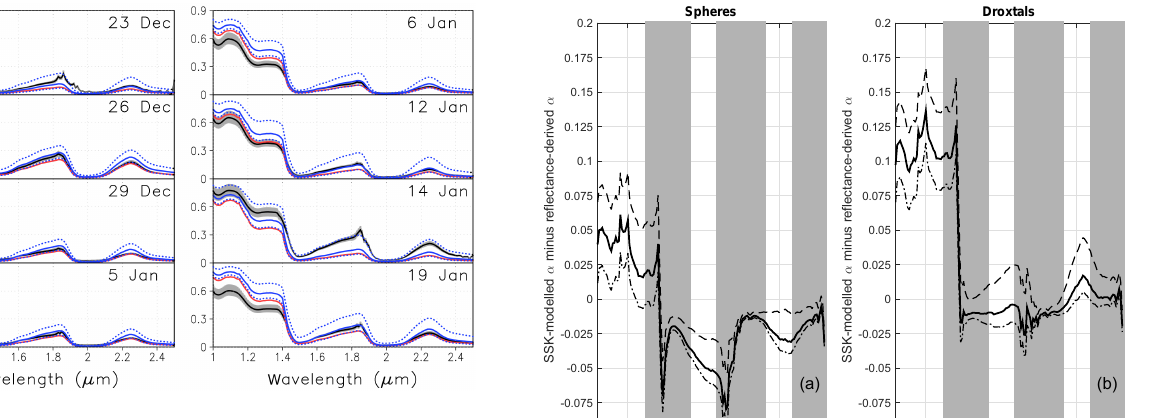
Figure 9. Spectral snow albedo obtained from reflectance measure- ments (black line) and calculated with DISORT using spherical par- ticle shapes (red line) and droxtal particle shapes (blue line) for all case studies. In the model calculations, we applied the observed snow density and the grain distribution based on the SSK metric. The grey shaded areas mark the total uncertainties on the albedo derived from reflectance observations (Eqs. (A1) and (A2) in Ap- pendix A), while the blue dotted lines represent the uncertainty in the droxtal model calculations due to the uncertainty in the metric distributions (Eqs. (A3) and (A4) in Appendix A). For the calcula- tions with spheres, the magnitude of uncertainty is comparable to the uncertainty in the droxtal calculations (not shown).